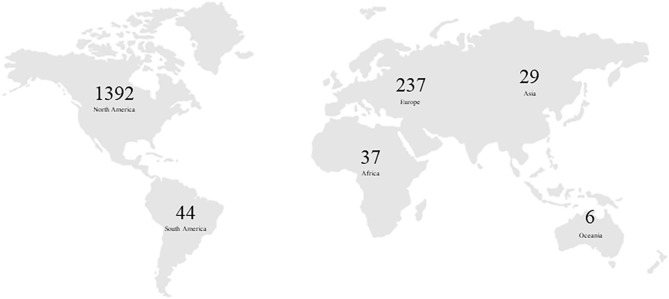
Number of players drafted per continent (between 1990 and 2019).